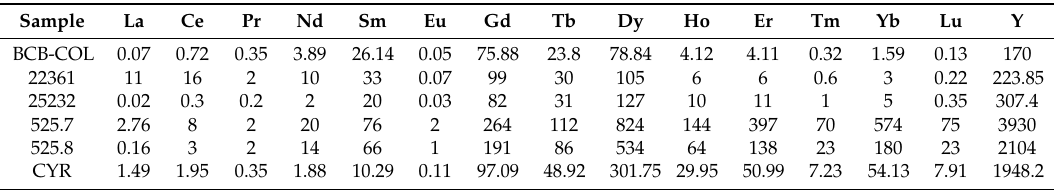
Table 3. Rare earth elements in columbite and “cyrtolite” by LA-ICP-MS (ppm) (five analyses on each